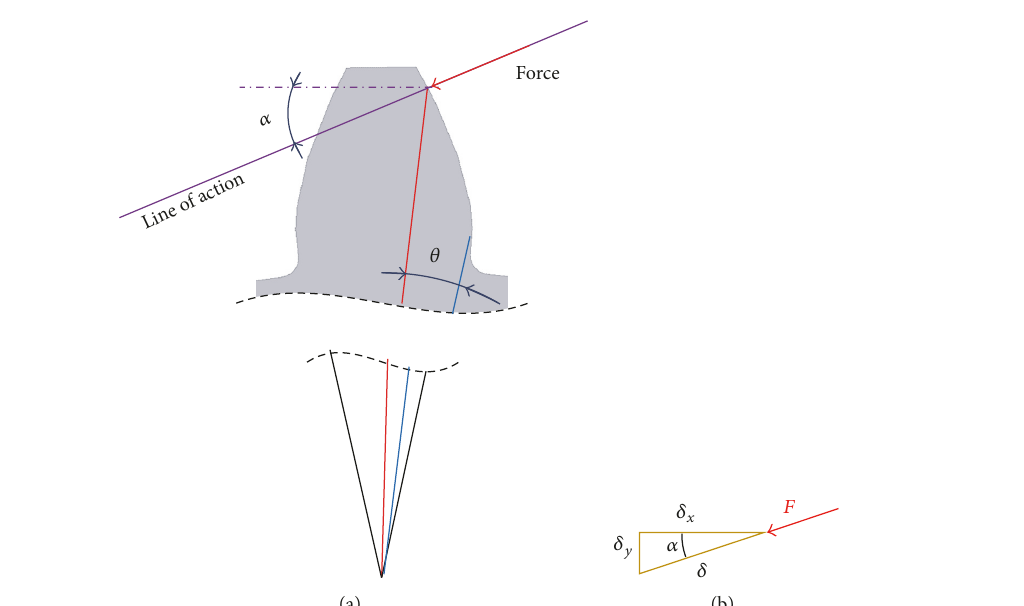
Figure 8: Transmitted force: (a) normal to the tooth face and parallel to the line of action and (b) resolving the displacement components